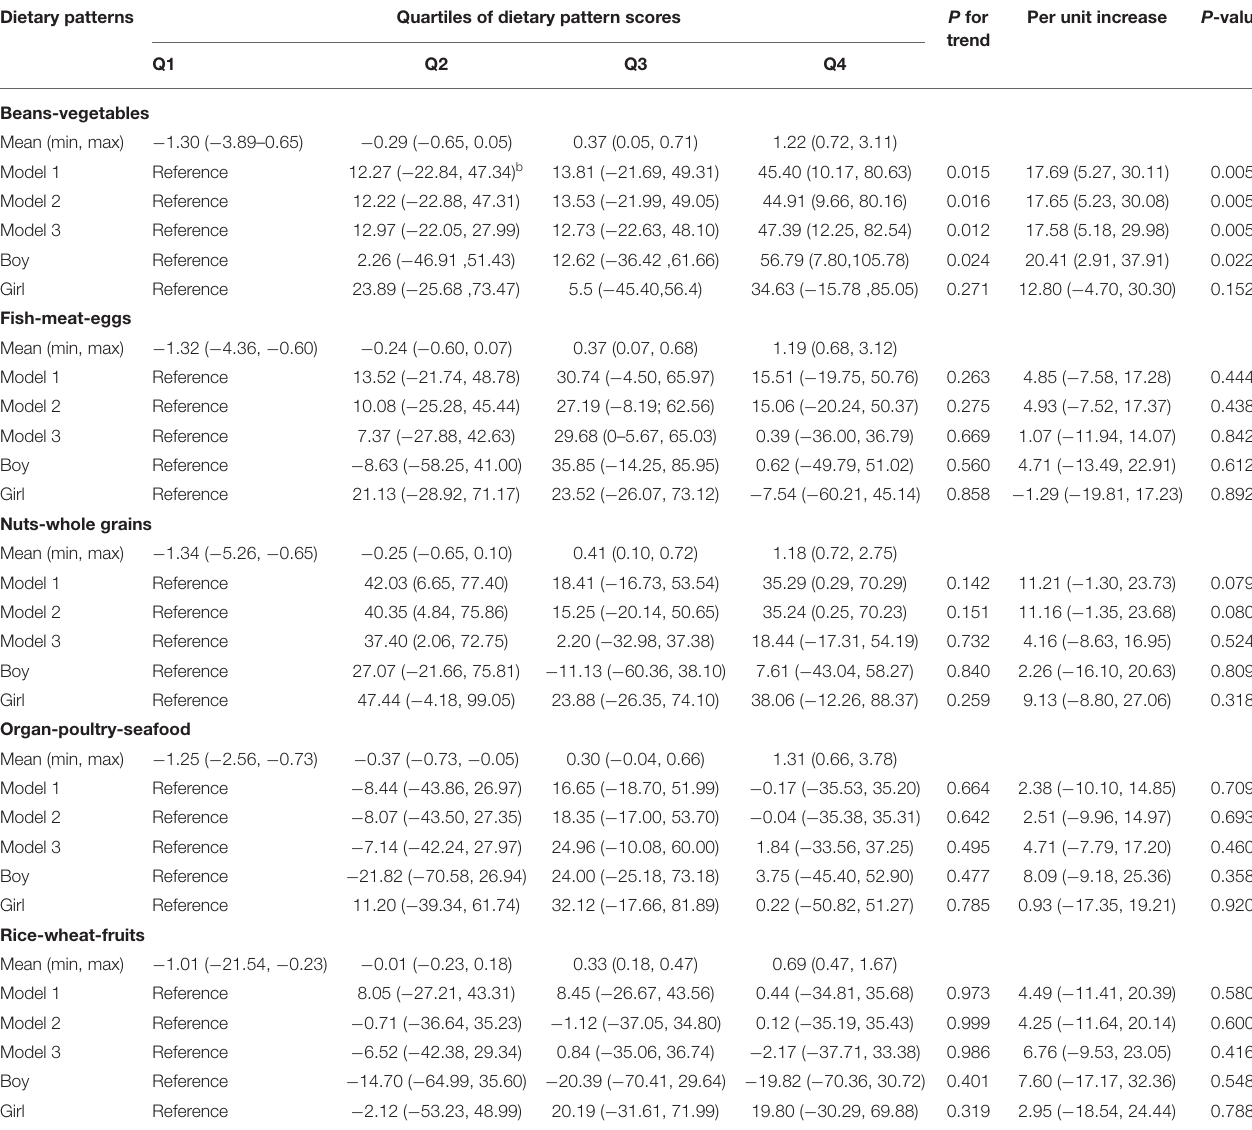
TABLE 2 | Associations between dietary pattern scores and normal birth weight (g) ( n = 2,847) a . Dietary patterns Quartiles of dietary pattern scores P for